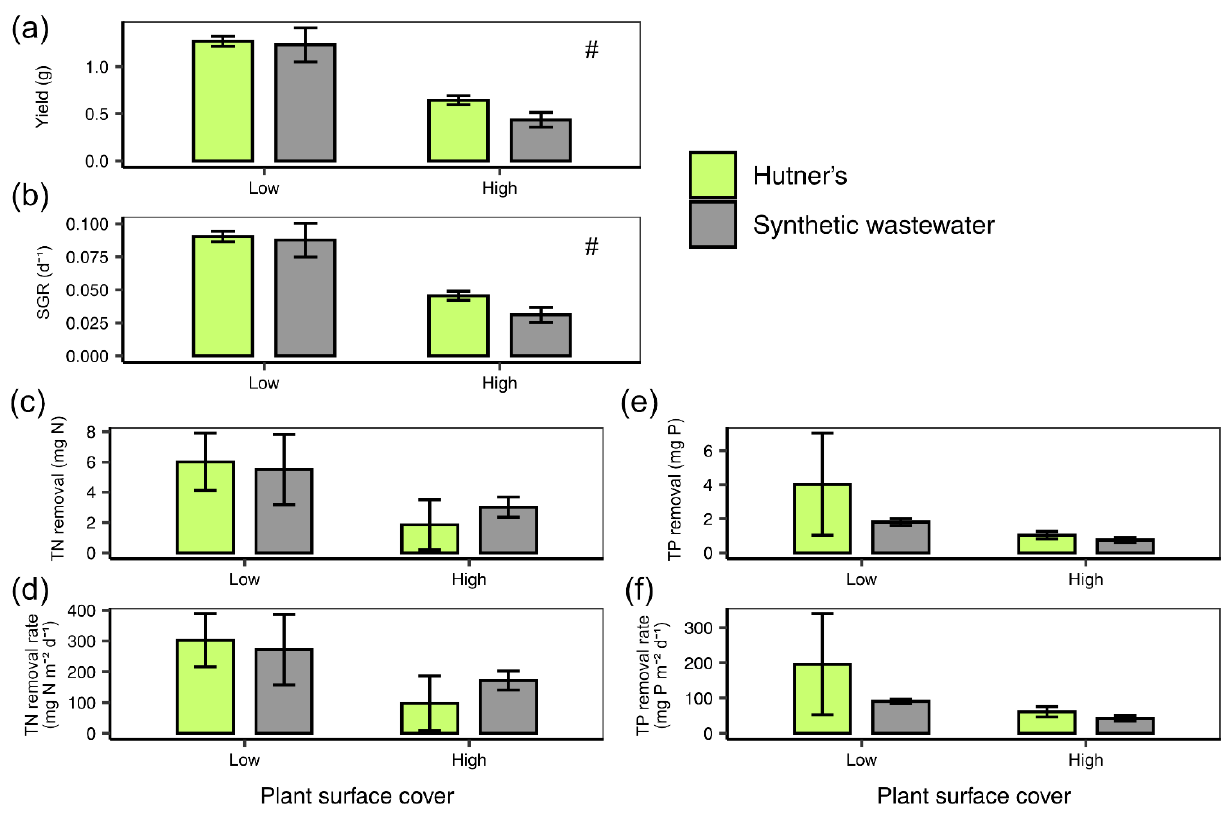
Figure 3. Mean ( ± SE) ( a ) yield (g), ( b ) SGR (d − 1 ), ( c ) TN removal (mg N), ( d ) TN removal rate per frond surface area (mg N m −2 d −1 ), ( e ) TP removal (mg P) and ( f ) TP removal rate per frond surface area (mg P m −2 d −1 ), for L. minor grown on synthetic wastewater or half- strength Hutner’s medium at two plant surface covers (low, 25 % and high, 60%) over 7 days. A hash symbol (#) denotes an effect of density for p < 0.05, as per the two-way ANOVA.